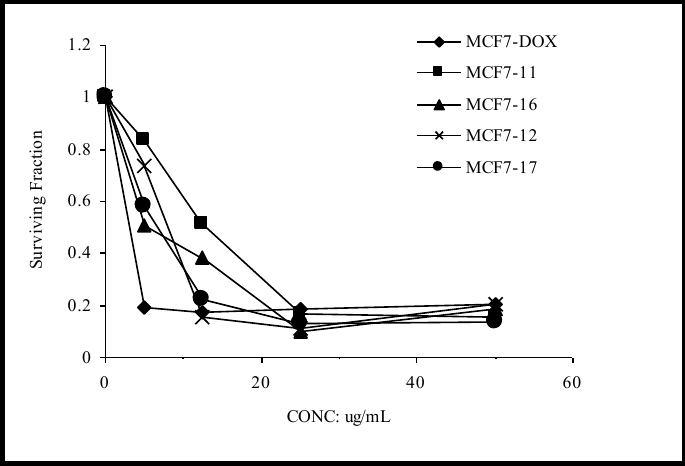
Figure (1): Drug cytotoxicity of product 11,16,12,17 compared to